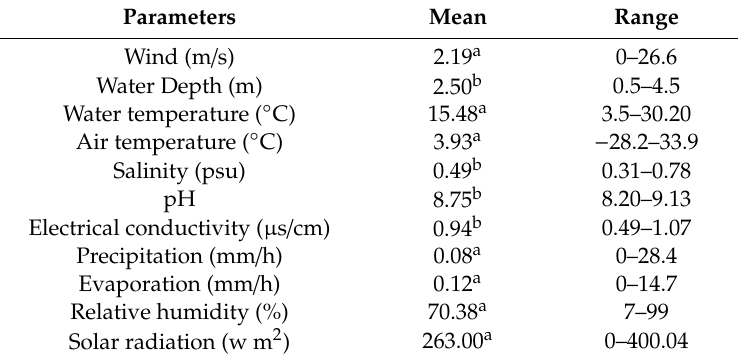
Table 1. Physical and chemical characteristics of Chagan